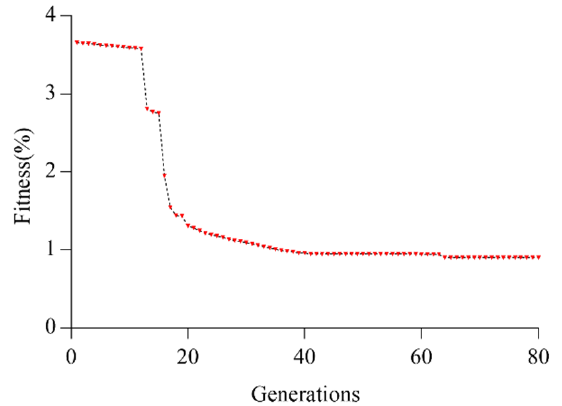
Figure 6. Particle swarm optimization convergence graph.